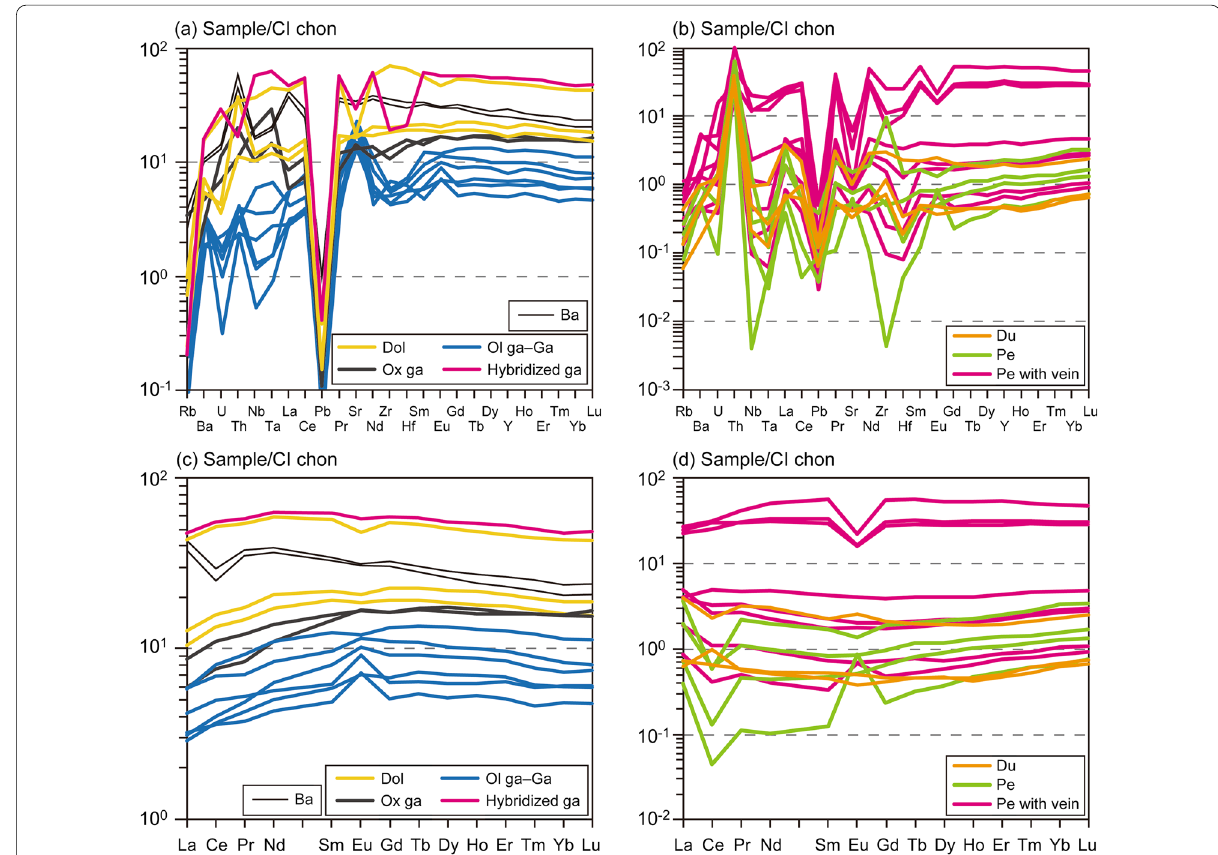
Fig. 7 CI chondrite‑normalized bulk trace‑element patterns. Mado Megamullion basalt compositions are from Basch et al. (2020). CI chondrite values are after Sun and McDonough (1989). Abbreviations: CI chon Ol ga olivine gabbro, Du dunite, and Pe = = =